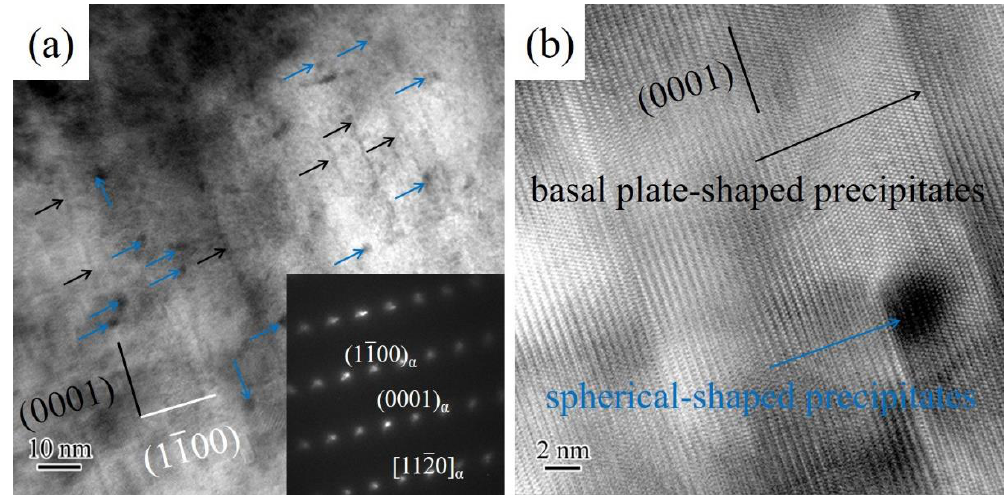
Figure 3. TEM images of aged Mg-2.0Nd-2.0Sm-0.4Zn-0.4Zr alloy with solution treatment for 2 h: ( a ) bright-field image and SAED patterns, ( b ) HRTEM of spherical-shaped precipitates and basal plate-shaped precipitates. The incident electron beam direction is parallel to the [112 ̅ 0] α .